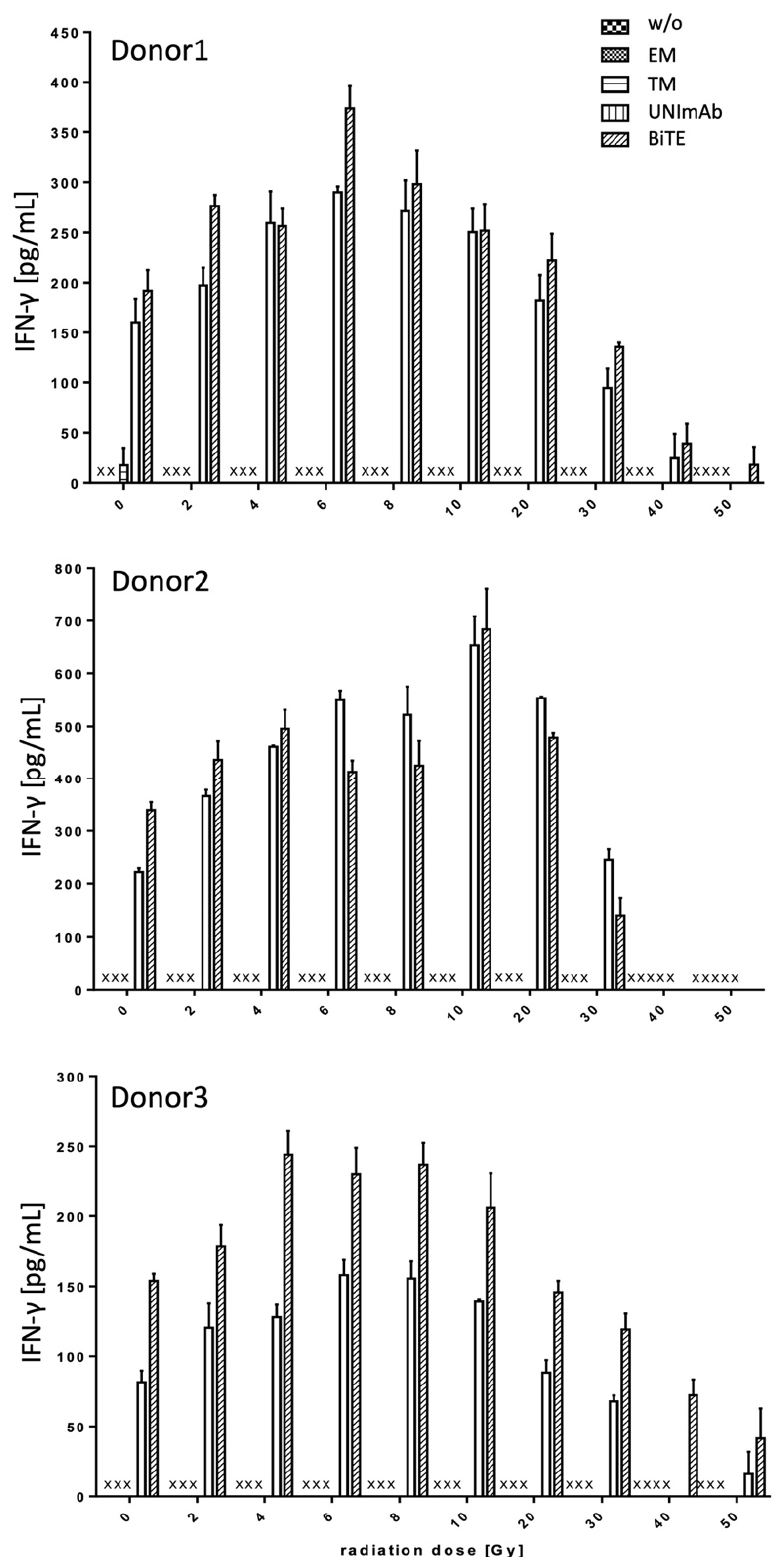
Figure 4. Release of Interferon- γ . The concentrations of Interferon- γ (IFN- γ ) were measured in supernatants via ELISA. The mean cytokine concentrations ± SD of triplicates for three different donors are shown. (x… not detectable).